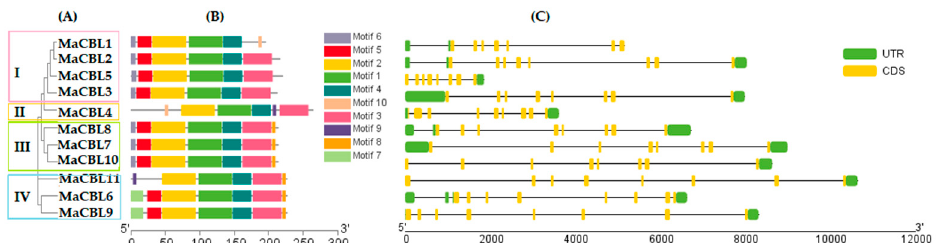
Figure 2. Phylogenetic clustering, conserved motifs and exon/intron organization of MaCBL genes. ( A ) The phylogenetic tree was constructed based on MaCBL proteins. ( B ) The motifs of each of the MaCBLs, and 10 different motifs, are each denoted by different colored boxes. ( C ) Exon/intron organization of MaCBLs. Untranslated (UTR) 5 ′ - and 3 ′ -regions are indicated by green boxes, exon regions are indicated by yellow frames, and intron regions are indicated by black lines.